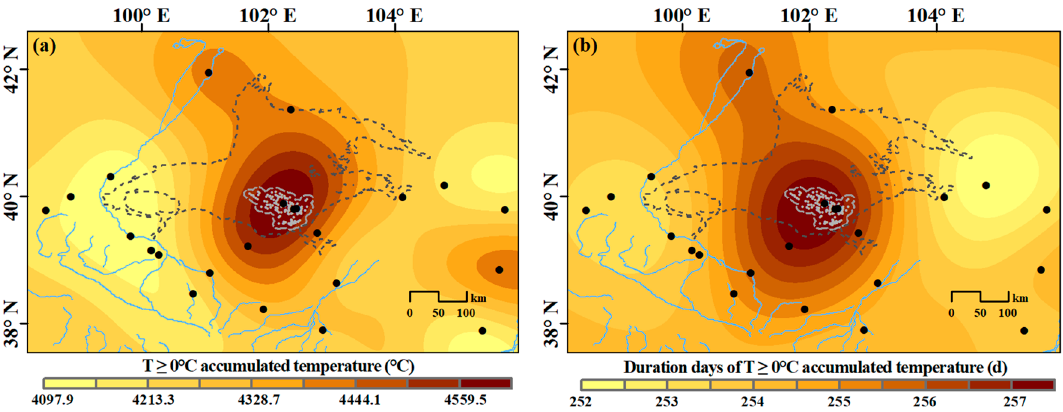
Figure 2. ( a ) Spatial distribution of T ≥ 0 °C accumulated temperature and ( b ) duration days from 2010 to 2017 over the BJD study area.